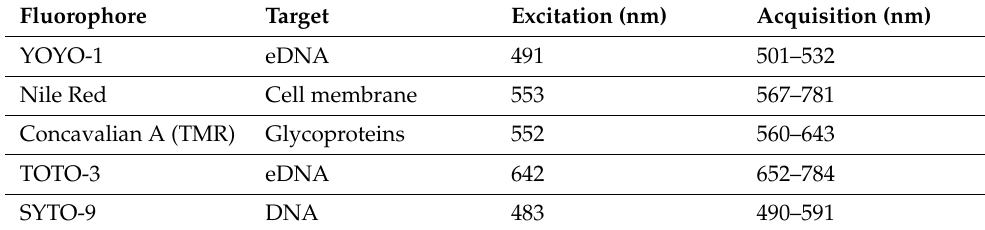
Table 1. List of fluorophores and the excitation and acquisition wavelengths of